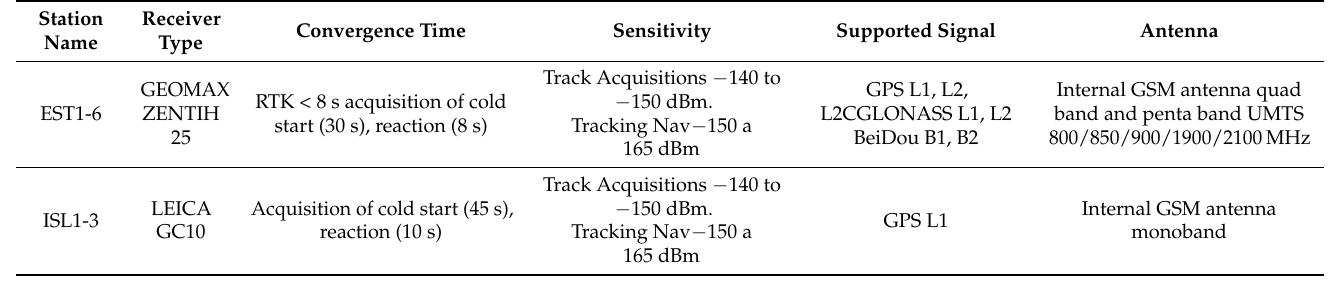
Table 2. Characteristics of the geodetic receivers.